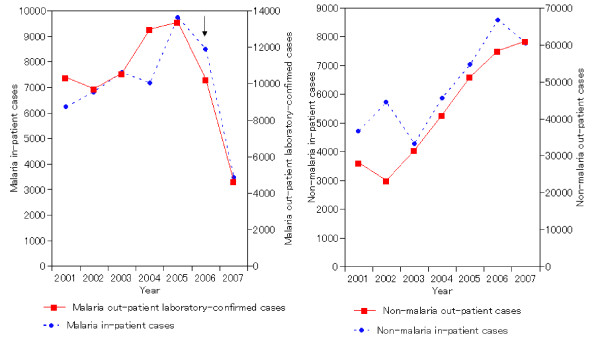
Malaria and non-malaria in- and out-patient cases, children < 5 years old, January to October 2001–2007, Rwanda. LLIN = long-lasting insecticidal nets, ACT = artemisinin-based combination therapy medicines.